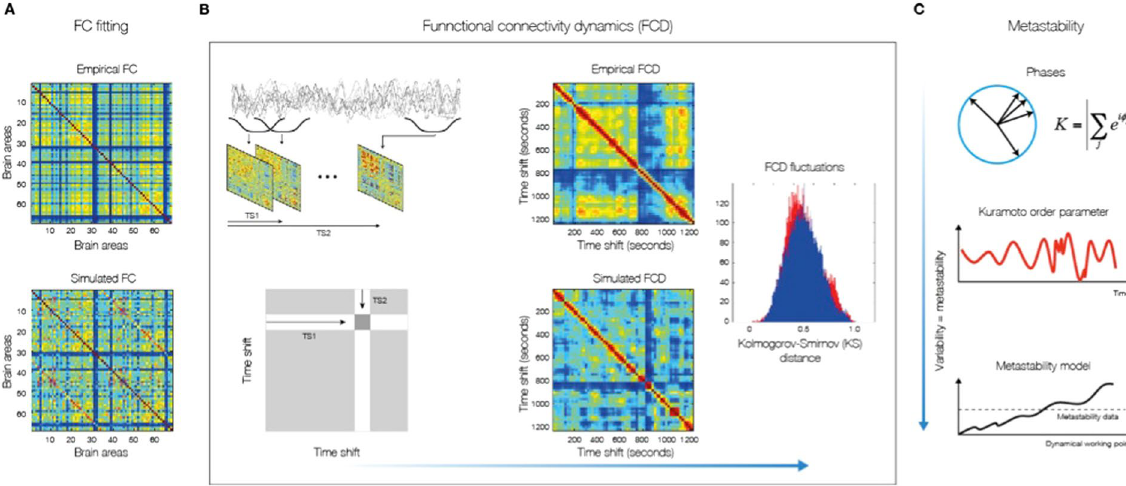
Figure 1. Methods for measuring fit between simulated and empirical data. ( A ) The fitting of the FC is measured by the Pearson correlation coefficient between corresponding elements of the upper triangular part of the matrices. ( B ) For comparing the FCD statistics, we collected the upper triangular elements of the matrices (over all participants or sessions) and compared the simulated and empirical distribution by means of the Kolmogorov-Smirnov distance between them. The Kolmogorov–Smirnov distance quantifies the maximal difference between the cumulative distribution functions of the two samples. ( C ) We measure the metastability as the standard deviation of the Kuramoto order parameter across time. The Kuramoto order parameter measures the global level of synchronization of the n oscillating signals. Under complete independence, the n phases are uniformly distributed and thus R is nearly zero, whereas R = 1 if all phases are equal (full synchronization). For calculating the metastability of the empirical and simulated BOLD signals, we first band-pass filtered within the narrowband 0.04–0.07 Hz and computed the instantaneous phase ϕ k (t) of each narrowband signal k using the Hilbert transform. The Hilbert transform yields the associated analytical signals. The analytic signal represents a narrowband signal, s(t), in the time domain as a rotating vector with an instantaneous phase, ϕ (t), and an instantaneous amplitude, A(t). Bottom panel visualizes a single example scenario (of many possible others) where the model system’s metastability increases as a function of G. We also indicate the metastability measured in empirical data. Part of figure B is based on the work of Allen and colleagues 44